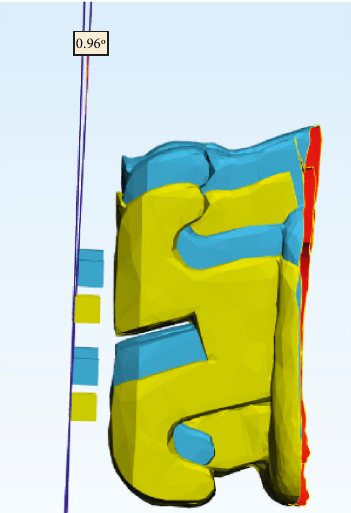
Figure 11: Measurement of the angular deviation (torque differ- ence) between the superimposed models.